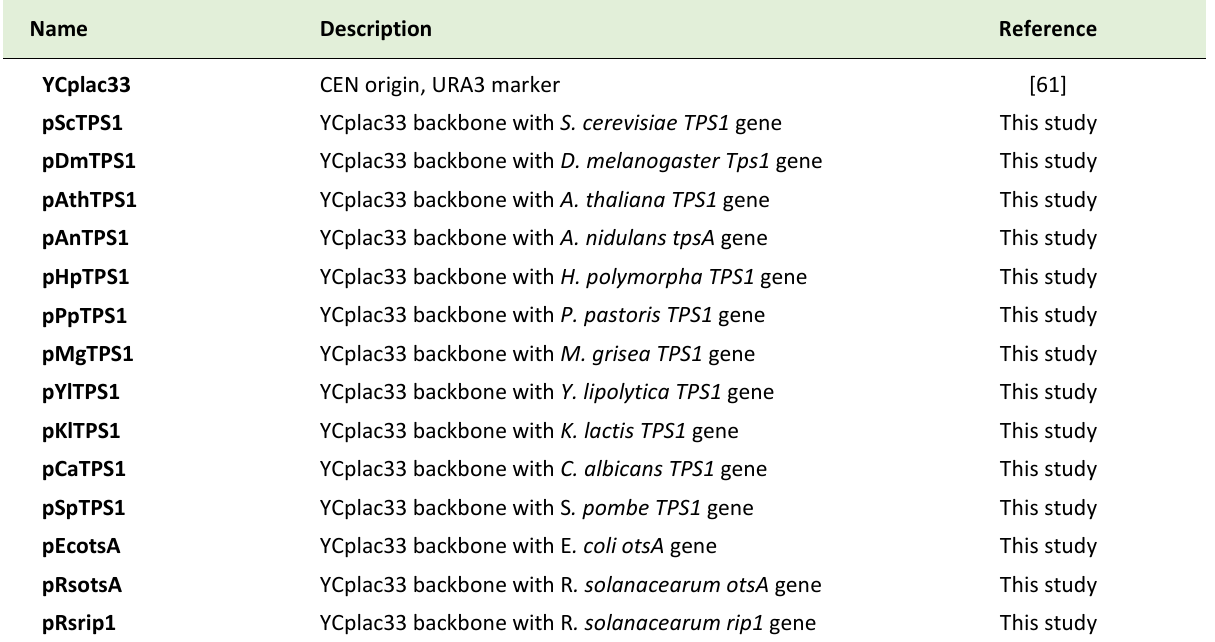
TABLE 3. List of plasmids used in this